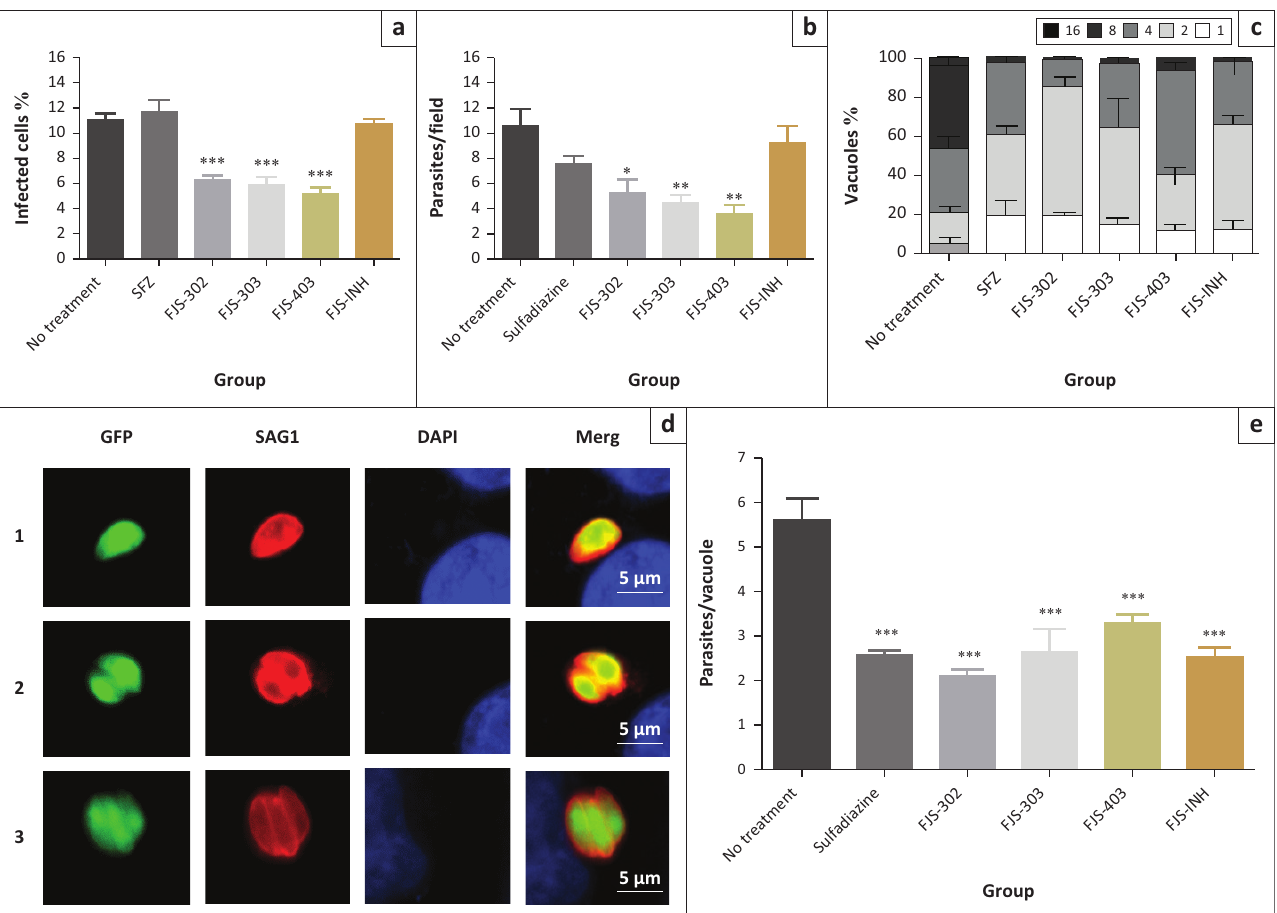
FIGURE 3: Effects of FJS-302, FJS-303, FJS-403 and FJS-INH on Toxoplasma gondii invasion and replication. FJS-302 (10 mg/mL), FJS-303 (12.5 mg/mL), FJS-403 (12.5 mg/ mL), FJS-INH (50 mg/mL) and sulphadiazine (1 mg/mL). (a) The percentage of infected cells was evaluated by counting the number of SAG1-positive Vero cells per 100 Vero cells by using IFAT. Each bar represents the mean ± s.d. of three independent experiments. (b) The number of parasites per field was measured by using a microscope. At least 10 fields were randomly observed in each group. Each bar represents the mean ± s.d. of three independent experiments. (c) Representative images of T. gondii RH-GFP replication in Vero cells. (d) The number of parasites in parasitophorous vacuoles was measured by counting the number of SAG1-positive parasites per parasitophorous vacuole. Each bar represents the mean ± s.d. of three independent experiments. (e) The average number of parasites per parasitophorous vacuole. Each bar represents the mean ± s.d. of three independent